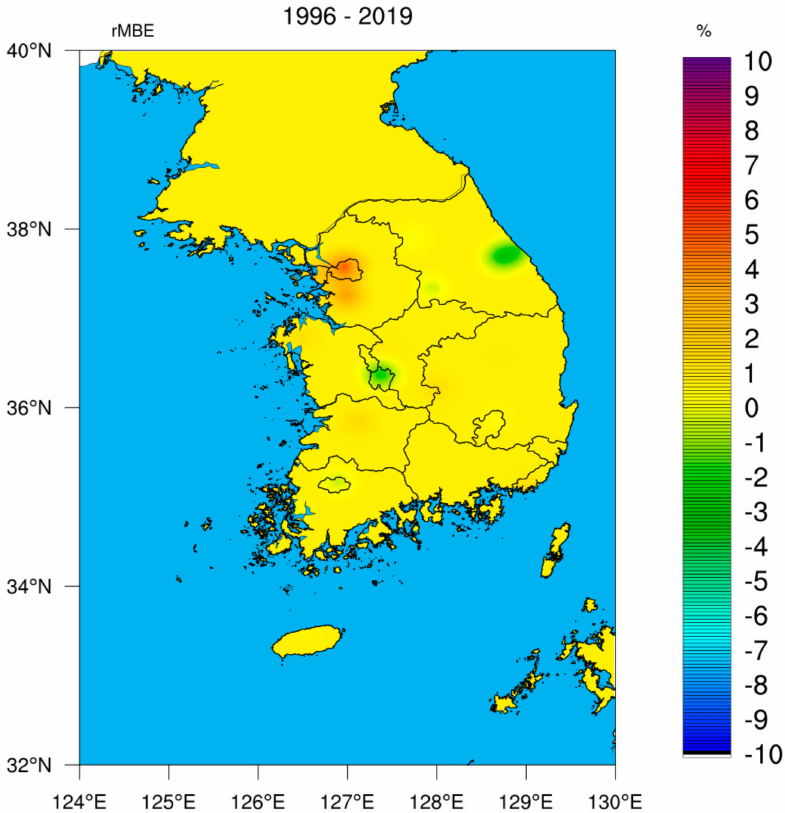
Figure 4. The relative mean bias error for the monthly mean of daily total irradiance that is estimated by the UASBIS–KIER model with satellite imagery from 1996 to